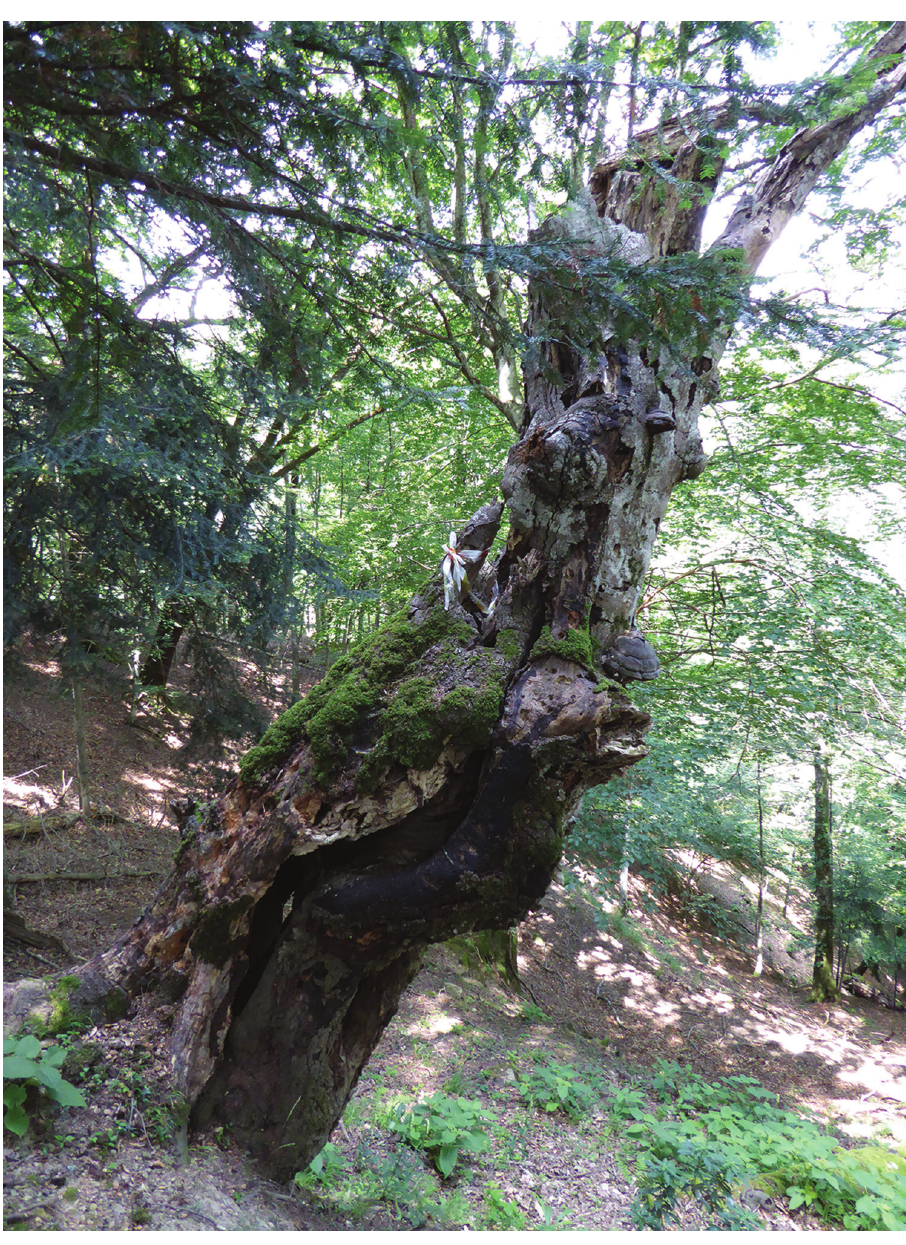
Figure 2. A wild tree used as sampling unit for the monitoring of R. alpina in the Foreste Casentinesi during